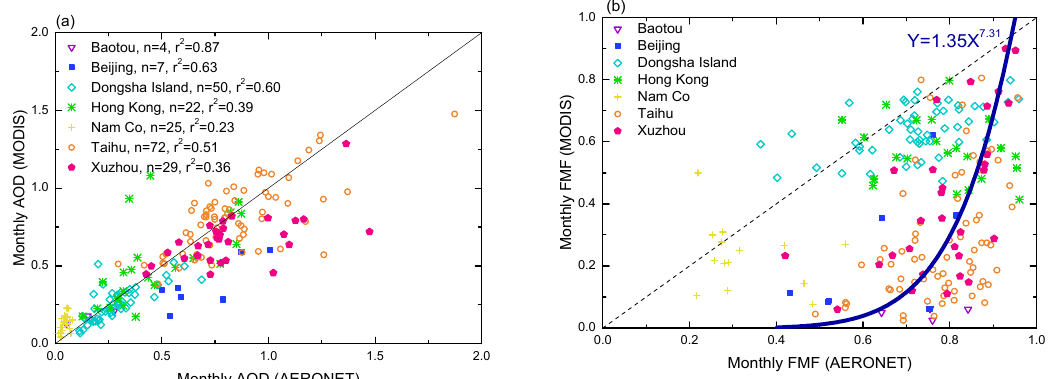
Figure 3. Comparison of monthly MODIS ( a ) aerosol optical depth (AOD) and ( b ) fine-mode fraction (FMF) data with AERONET measurements. The periods for which AERONET data are available vary at di ff erent sites and we used all data available from site establishment to 2015. The line in ( b ) indicates a power law fit of the FMF data (excluding the Nam Co, Hong Kong and Dongsha Island sites) and the relation describing the fit is indicated at the top of the figure, at the